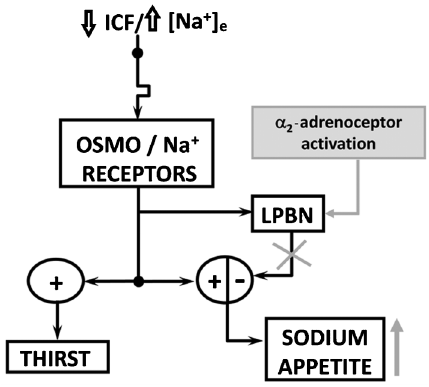
Figure 1. Diagram showing the possible involvement of the lateral parabrachial nucleus (LPBN) in the control of thirst and sodium appetite during cell dehydration. Osmoreceptors or sodium receptors activate circuits that subserve thirst and sodium appetite, and a parallel inhibitory circuit of sodium appetite involves the LPBN. The a 2 -adrenoceptor activation in the LPBN blocks this LPBN-inhibitory mechanism. ICF: intracellular fluid; [Na + ] e : extracellular sodium concentration. Adapted from Ref. 45, with